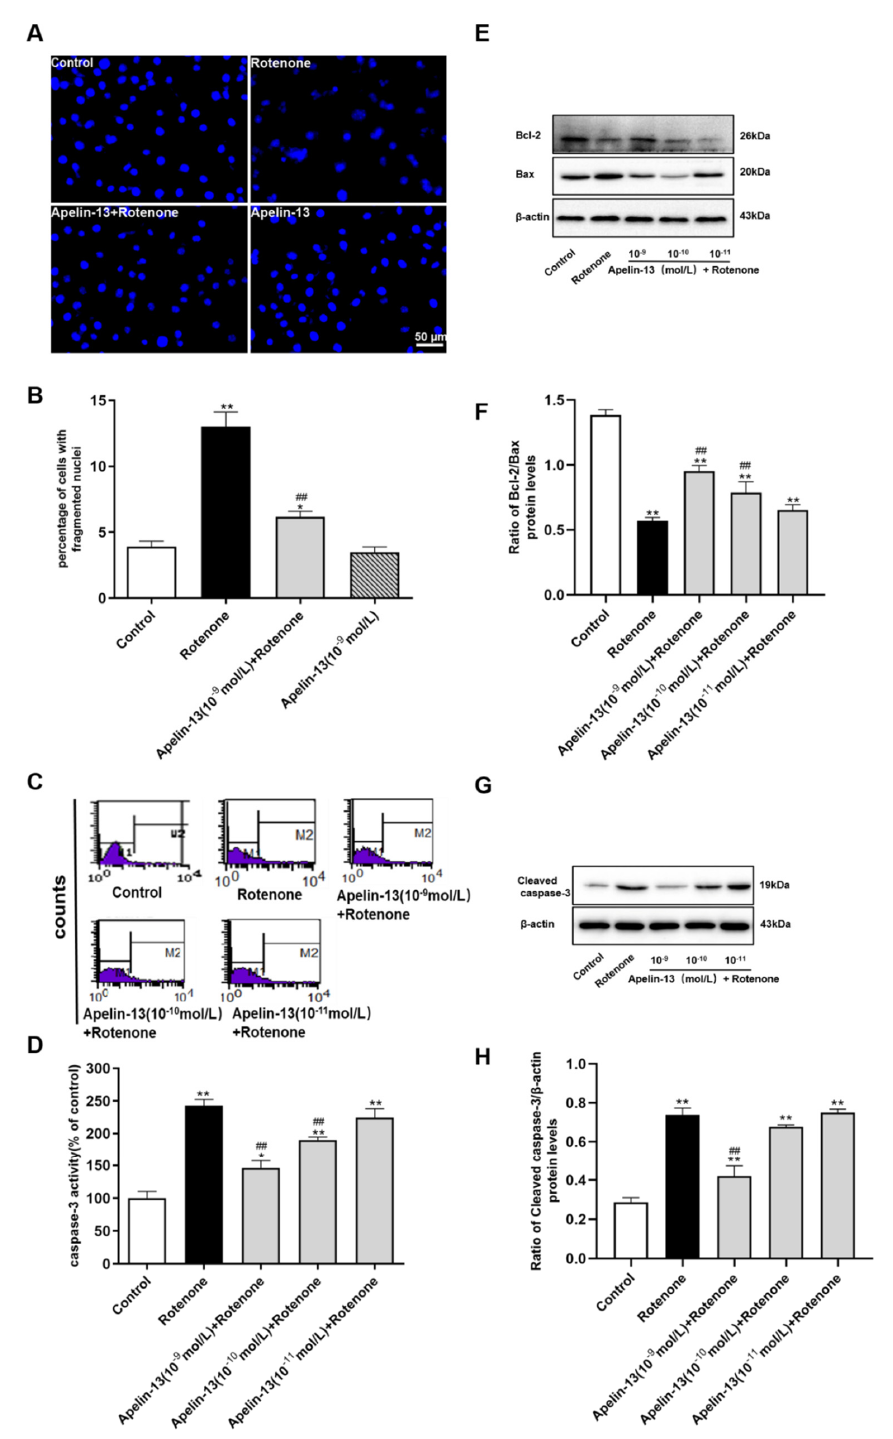
Figure 2. Effects of apelin-13 on rotenone-induced apoptosis in SH-SY5Y cells. ( A ) The cells with fragmented nuclei were measured by Hochest 33258 staining. Rotenone-induced nuclear condensation was attenuated by apelin-13 pretreatment. Bar = 50 μ m. ( B ) Statistical analysis. * p < 0.05; ** p < 0.01 compared with the control; # p < 0.05; ## p < 0.01 compared with the rotenone group. ( C ) Fluorometric assay of caspase-3 activity in cells treated with vehicle or apelin-13 (10 − 11 mol/L ~ 10 − 9 mol/L) prior to rotenone treatment for 24 h. Caspase-3 activity was increased in cells with rotenone treatment; however, this effect was attenuated by apelin-13 pretreatment. ( D ) Statistical analysis. Data